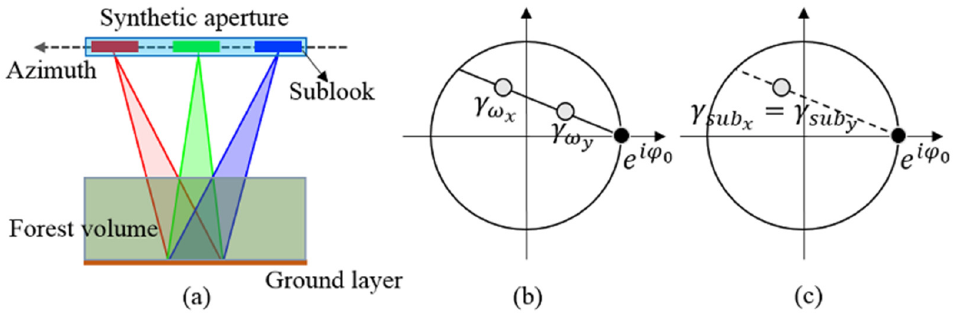
Figure 2. ( a ) Schematic representation of TF analysis over the homogeneous forest with a horizontal underlying topography. ( b , c ) Corresponding coherence loci of the polarimetric observations and sublook observations in the complex unit circle, respectively.